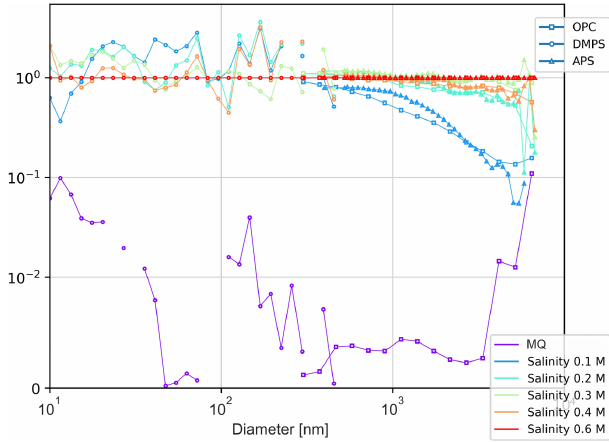
Figure 6. Salinity effect on particle size spectrum: the spectra for different salinities normalized with the spectrum of the salinity S = 0.6M.